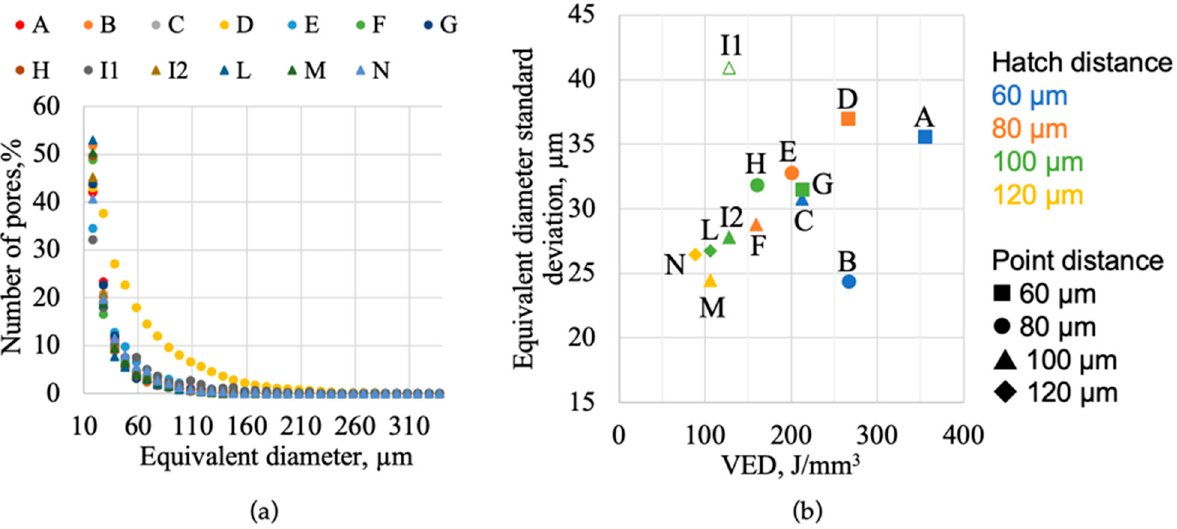
Figure 6. Pore size distribution described through: ( a ) percentage of pores per equivalent diameter (each point corresponds to an equivalent diameter range ± 5 µm), and ( b ) standard deviation of equivalent diameter as function of VED.